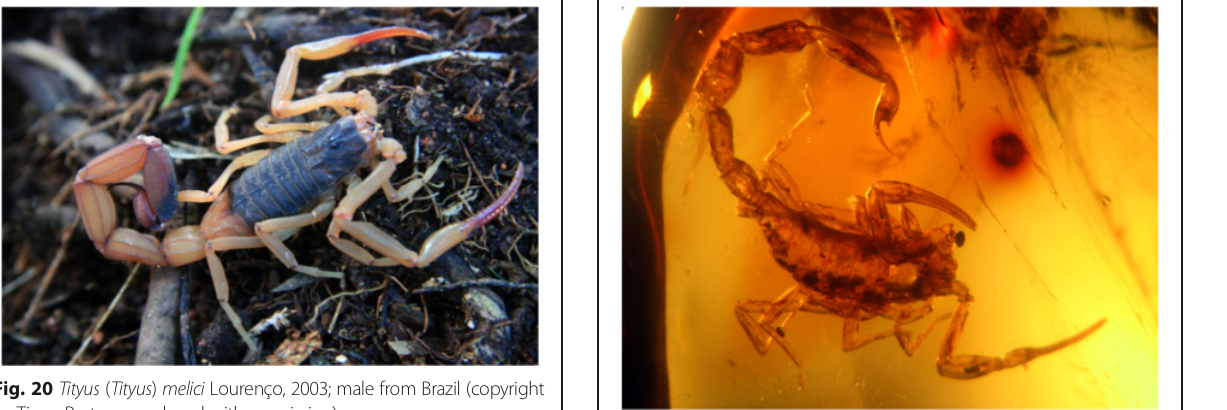
Fig. 22 Tityus ( Brazilotityus ) hartkorni Lourenço, 2009; male in Dominican Amber from the island of Hispaniola; Miocene